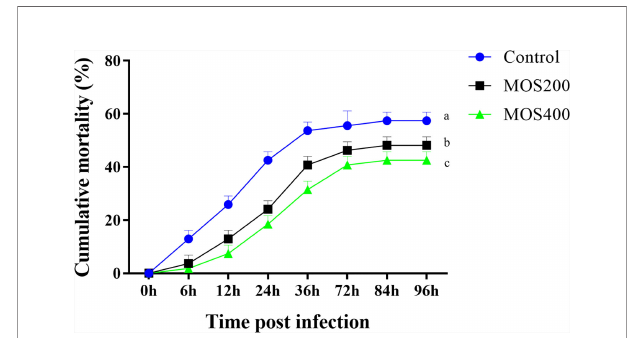
FIGURE 1 | Dietary MOS decreased the mortality of juvenile M. amblycephala post – bacterial infection. Different letters indicated signi fi cant differences among groups (P < 0.05).